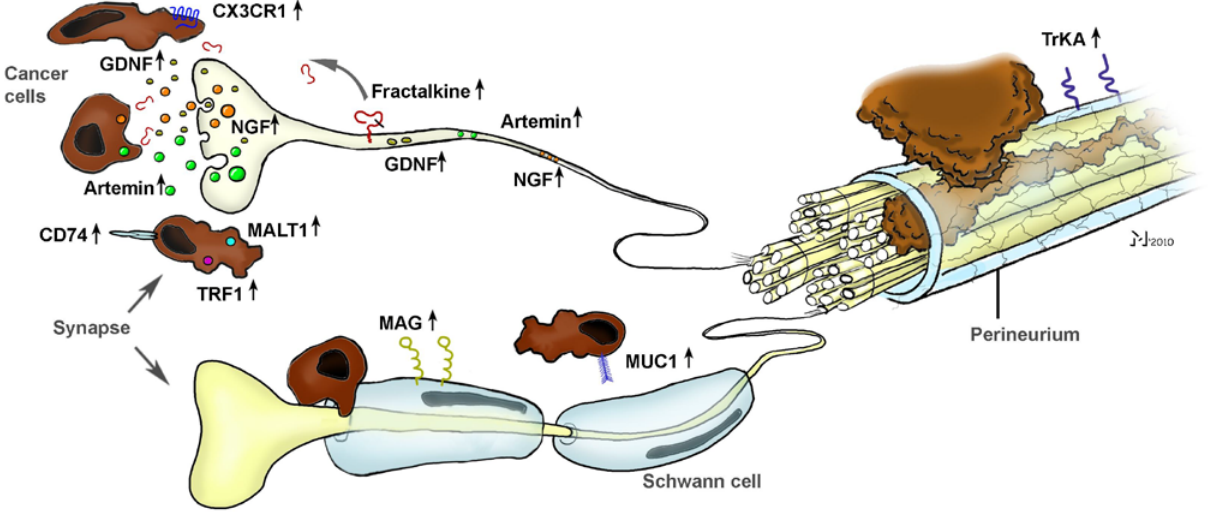
Figure 3. The interplay between neuronal and cancer-cell-derived factors in the generation of neural invasion (NI) in pancreatic cancer (PCa). Research from the past 10 years has revealed a crucial involvement of several neurotrophic factors (e.g., NGF, GDNF, artemin), chemokines (e.g., fractalkine), pro-survival genes (MALT1, TRAF) and cell-surface receptors (CD74, MAG) in the neuro-cancer interactions and NI in PCa. Please see the manuscript for the respective